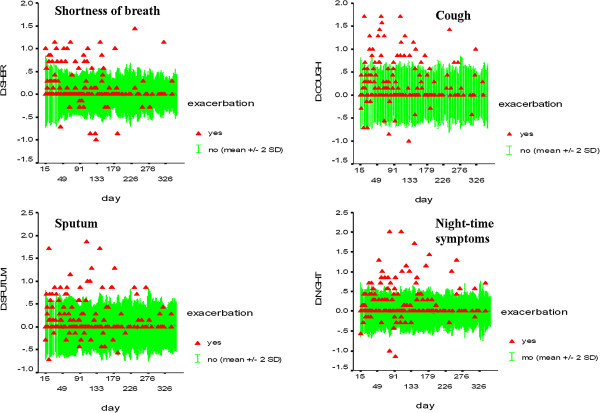
Graph of increases in moving weekly averages for the different symptom scores from the diaries at each day during follow-up. Triangles represent individual values of the increase at the day of a patient’s (first) exacerbation. The gray area represents the reference range at each day of follow-up, i.e. mean +/− 2 SD values of the increase for those who did not have an exacerbation at the days indicated.